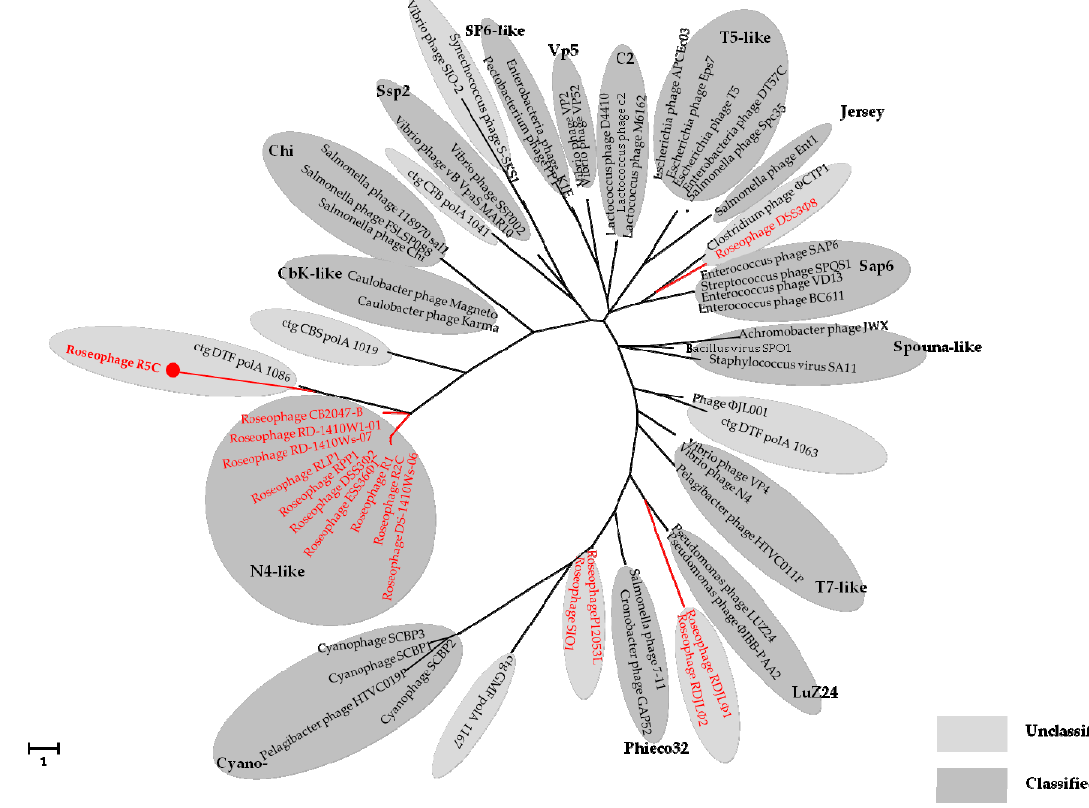
Figure 5. Unrooted maximum likelihood phylogenetic tree of DNA polymerase I of bacteriophages. Red color represents roseophages.